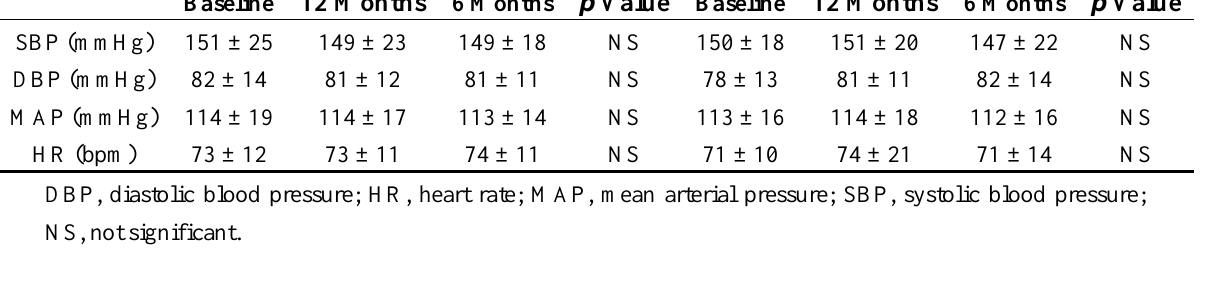
Table 4. Changes in blood pressure and heart rate during the treatment period. L -carnitine Group ( n = 67) Control Group ( n =